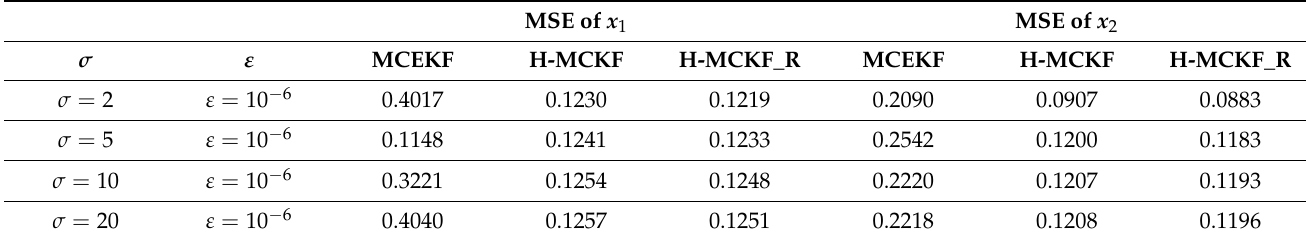
-6 5 σ= ,ε=10 Figure 7. ( a , b ) Set parameters: σ = 5, ε = 10 − 6 in case2; ( c , d ) set parameters: σ = 10, ε = 10 − 6 in Figure 7. ( a , b ) Set parameters: in case2; ( c , d ) set parameters: case 2. Table 3. The mean squared error using the three methods in case 2. Table 3. The mean squared error using the three methods in case 2.